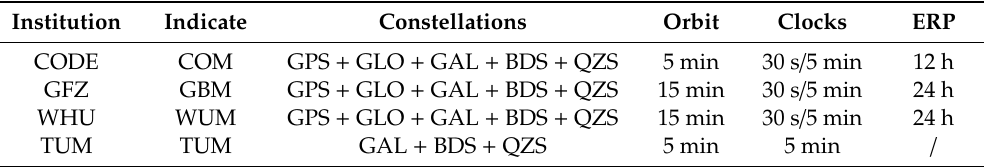
Table 2. The information about BDS orbit and clock products.